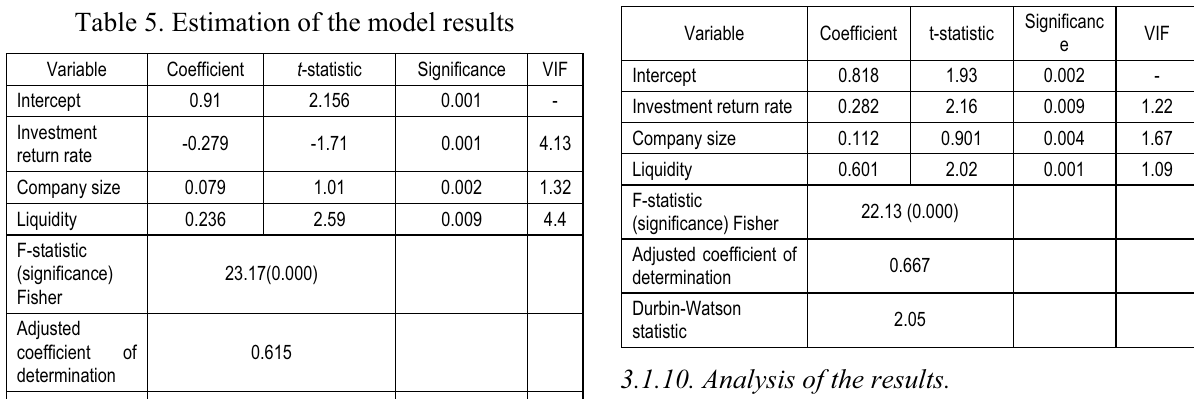
Table 6. Results of model